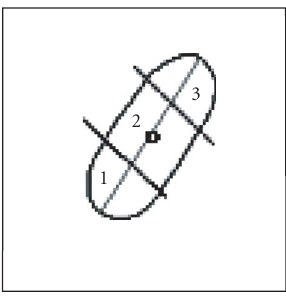
Figure 5: Single cell hypothetically divided into three